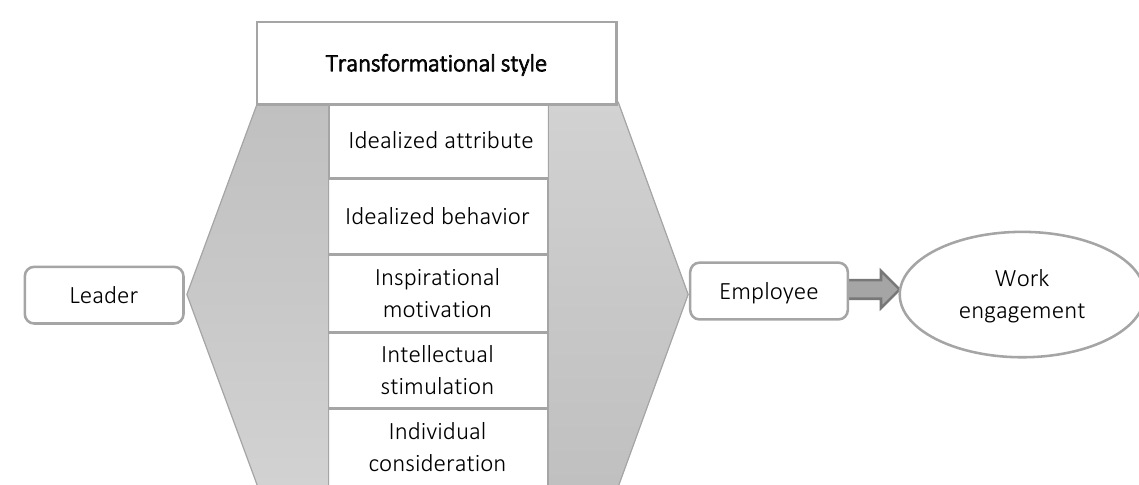
Figure 1. Conceptual framework